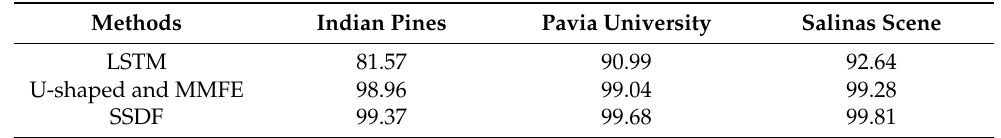
Table 3. The overall accuracy (%) of different